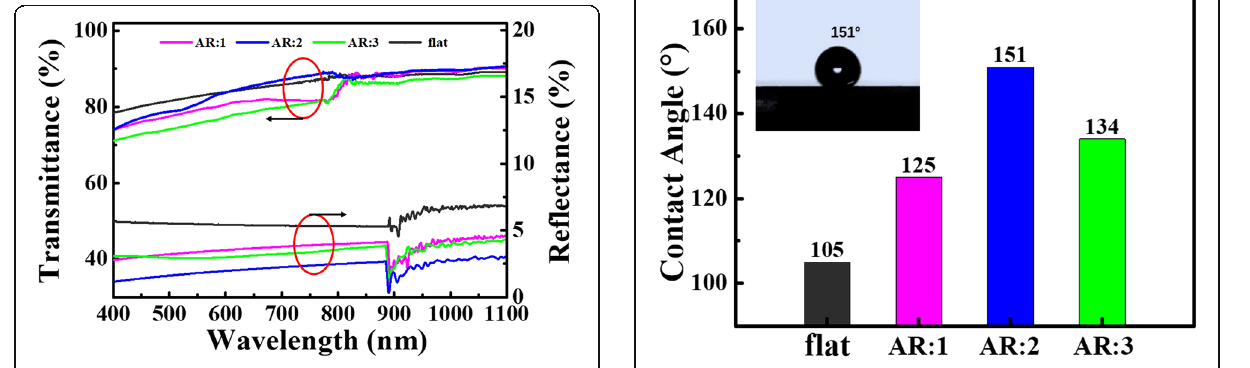
Fig. 3 Reflectance and transmittance measurements of the PDMS films with and without nanocone cluster microstructures